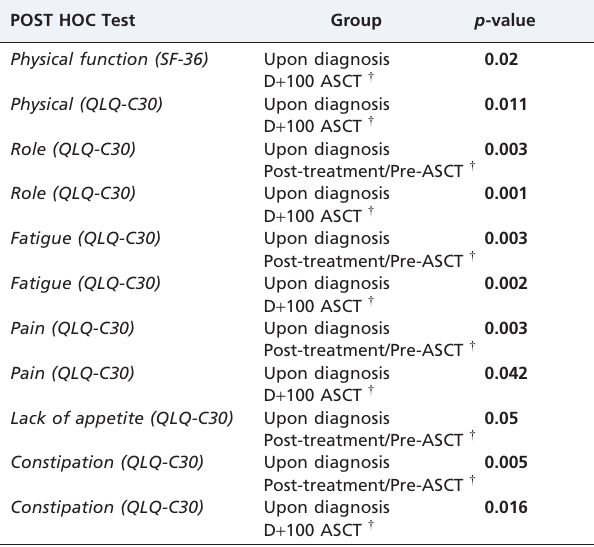
Table 4 - Post hoc tests comparing the three groups (two by